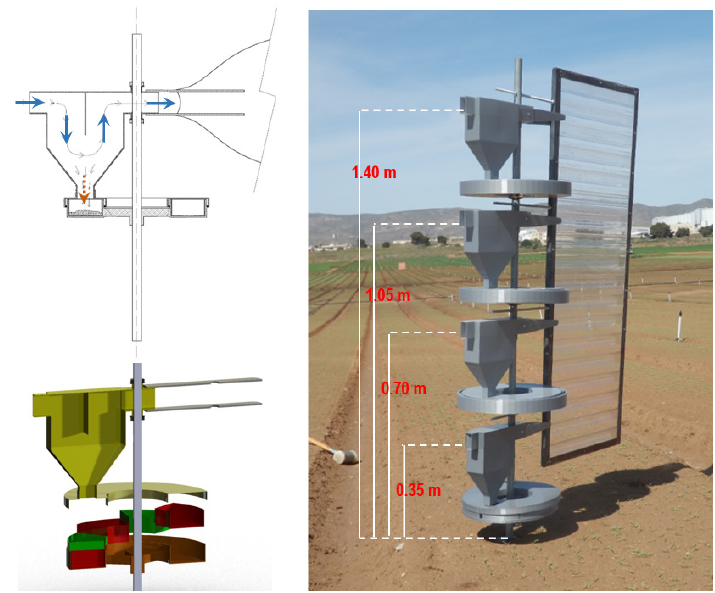
Figure 3. MDt collector schemes. Photo: mast and vane with collectors at different heights.